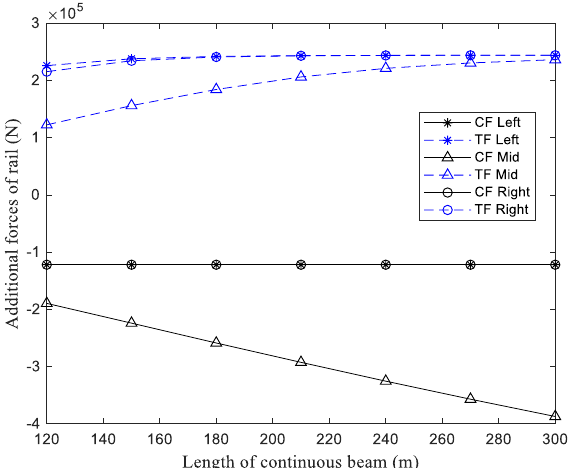
Figure 7. The curves of the minimum values of the maximum additional forces of rail changing with the length of the continuous beam for RER located at three positions. In the legend, CF and TF represent the compression and tension forces, respectively, and Left, Mid and Right represent RER located the above the left end, the middle, and the right end of the continuous beam, respectively.